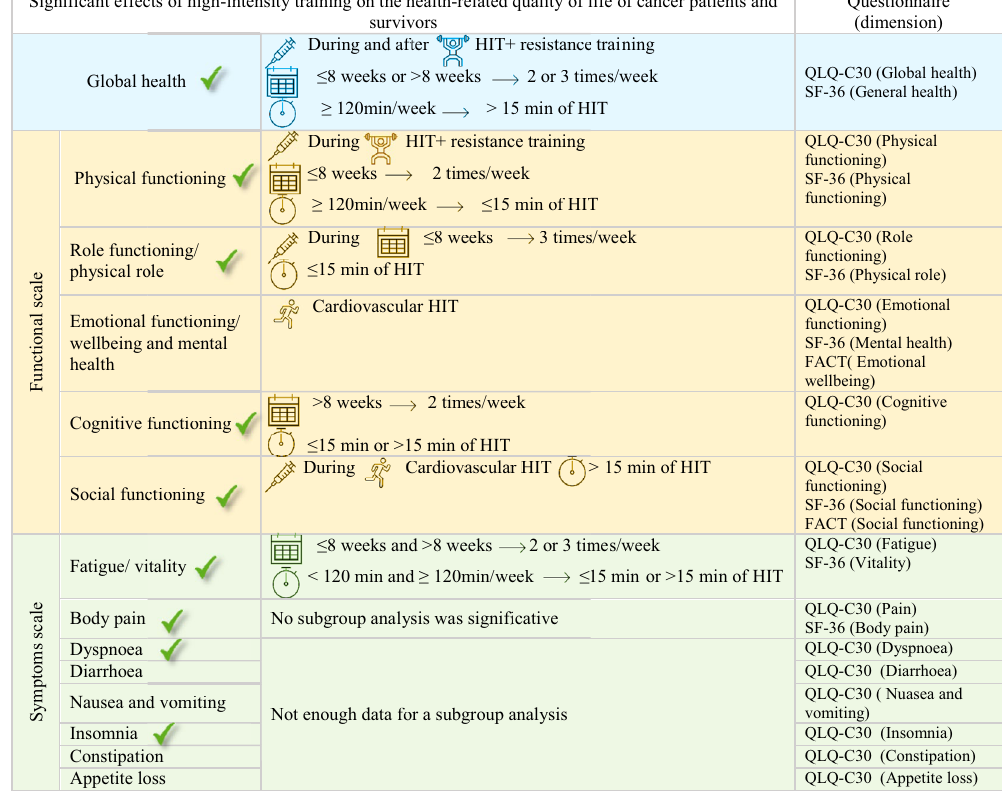
Table 4. Sum of HRQoL results obtained and the corresponding questionnaires used. : Significant differences between the control group and the high-intensity exercise group. No comparison between the high-intensity exercise group and the low-moderate group was significant. QLQ-C 30: European Organisation for Research and Treatment of Cancer quality of life Questionnaire, SF-36: Short-form 36, FACT-G: Functional Assessment of Cancer Therapy